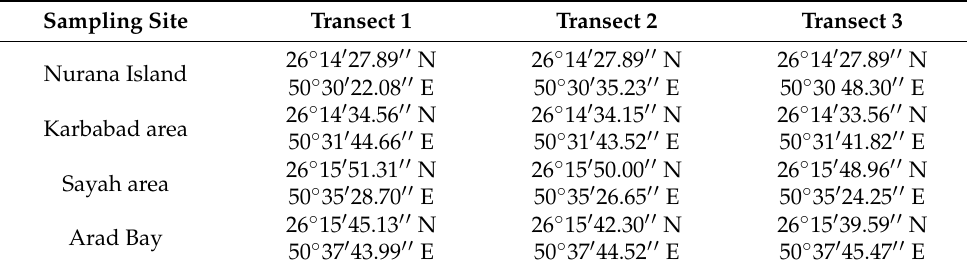
Table 1. Geographical coordinates of transects in the sampling